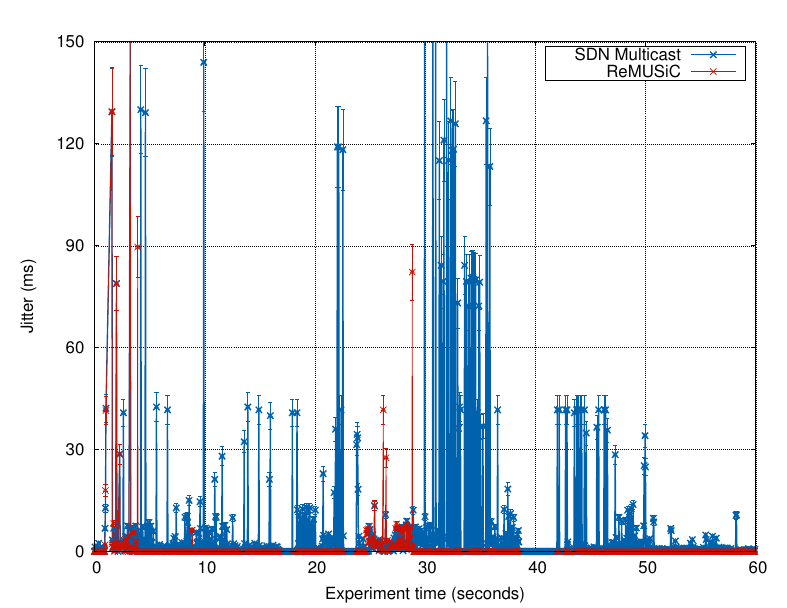
Figure 13. Jitter impact in both ReMUSiC and SDN Multicast